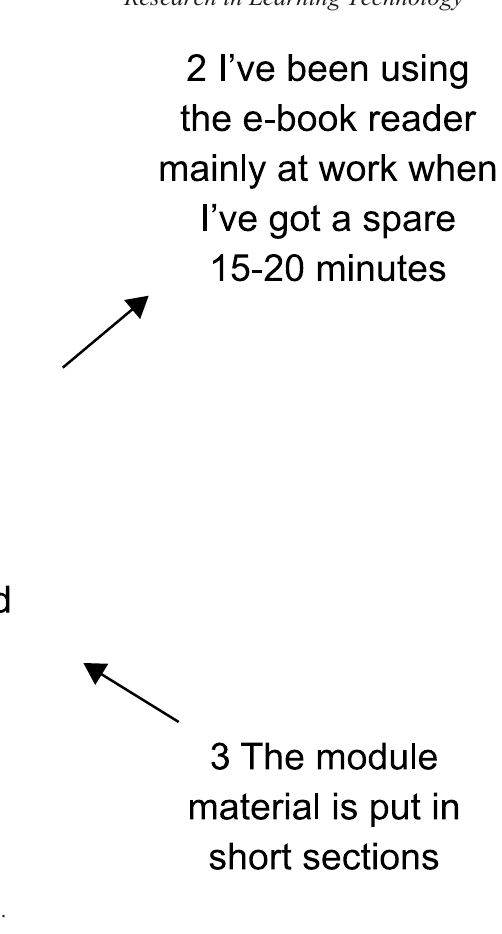
Figure 2. A fragment of a causal